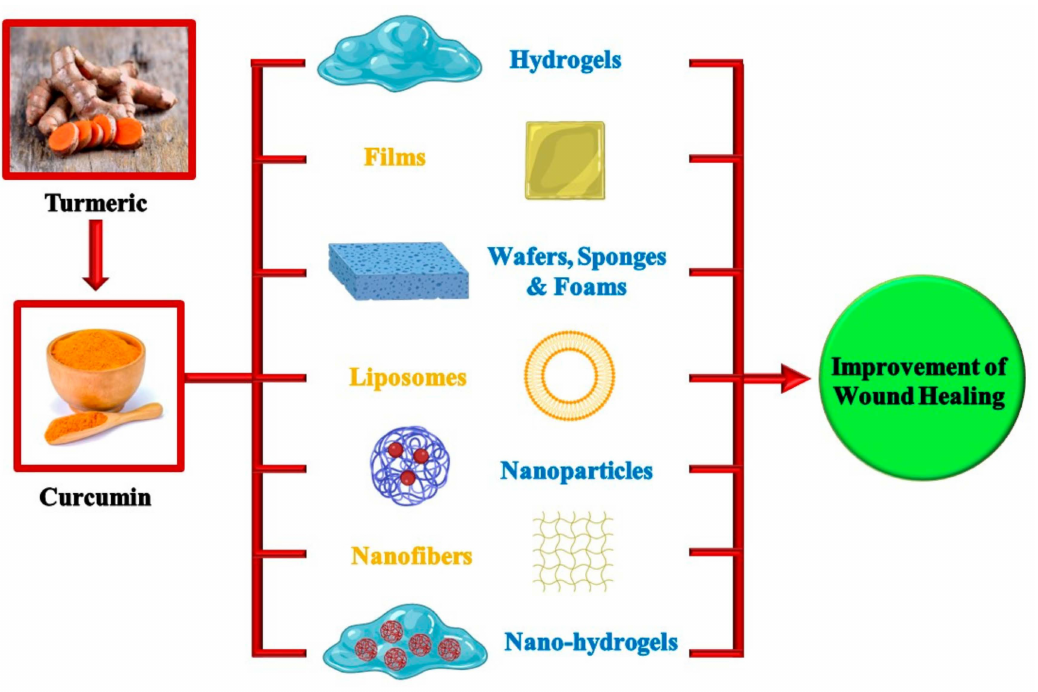
Figure 3. A collective illustrative diagram representing different dosage forms used for delivering curcumin at the wound site for better wound healing. (Created with BioRender.com; accessed on 12 December